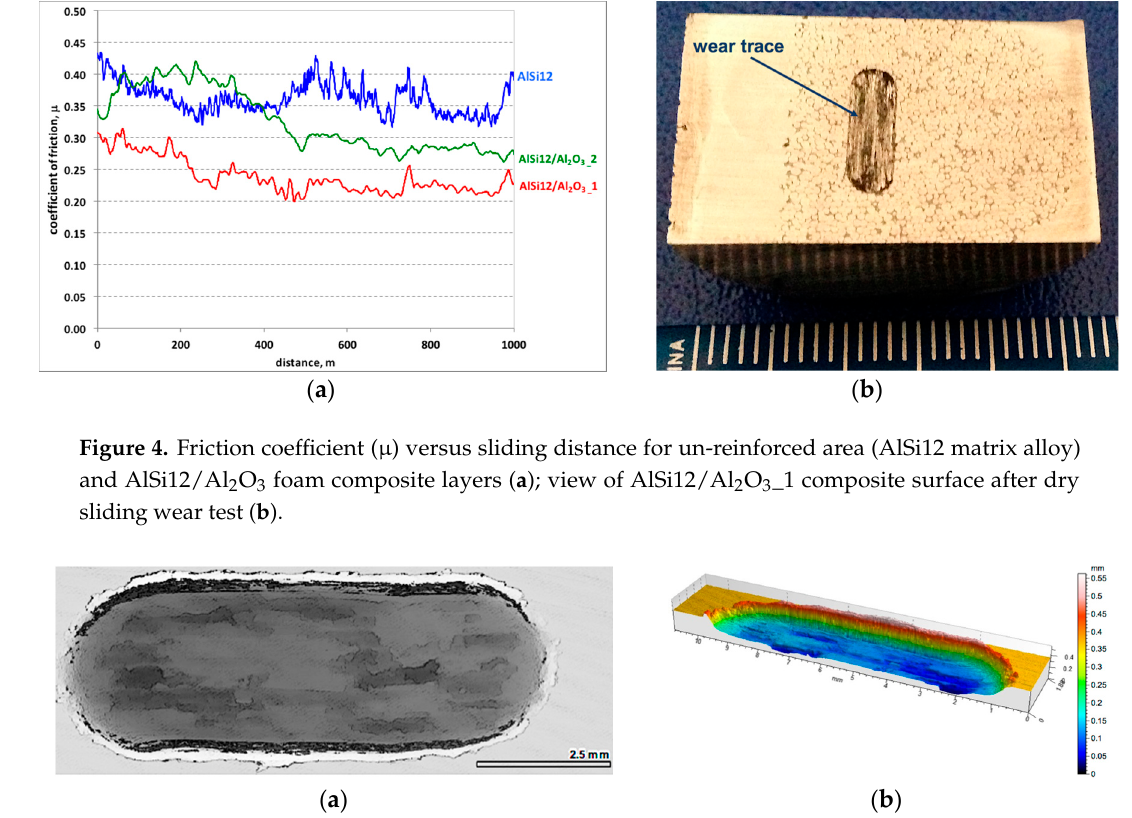
Figure 5. View of wear track in unreinforced area (AlSi12 matrix) after dry sliding condition: ( a ) digital image; ( b ) cross-section through 3D view.